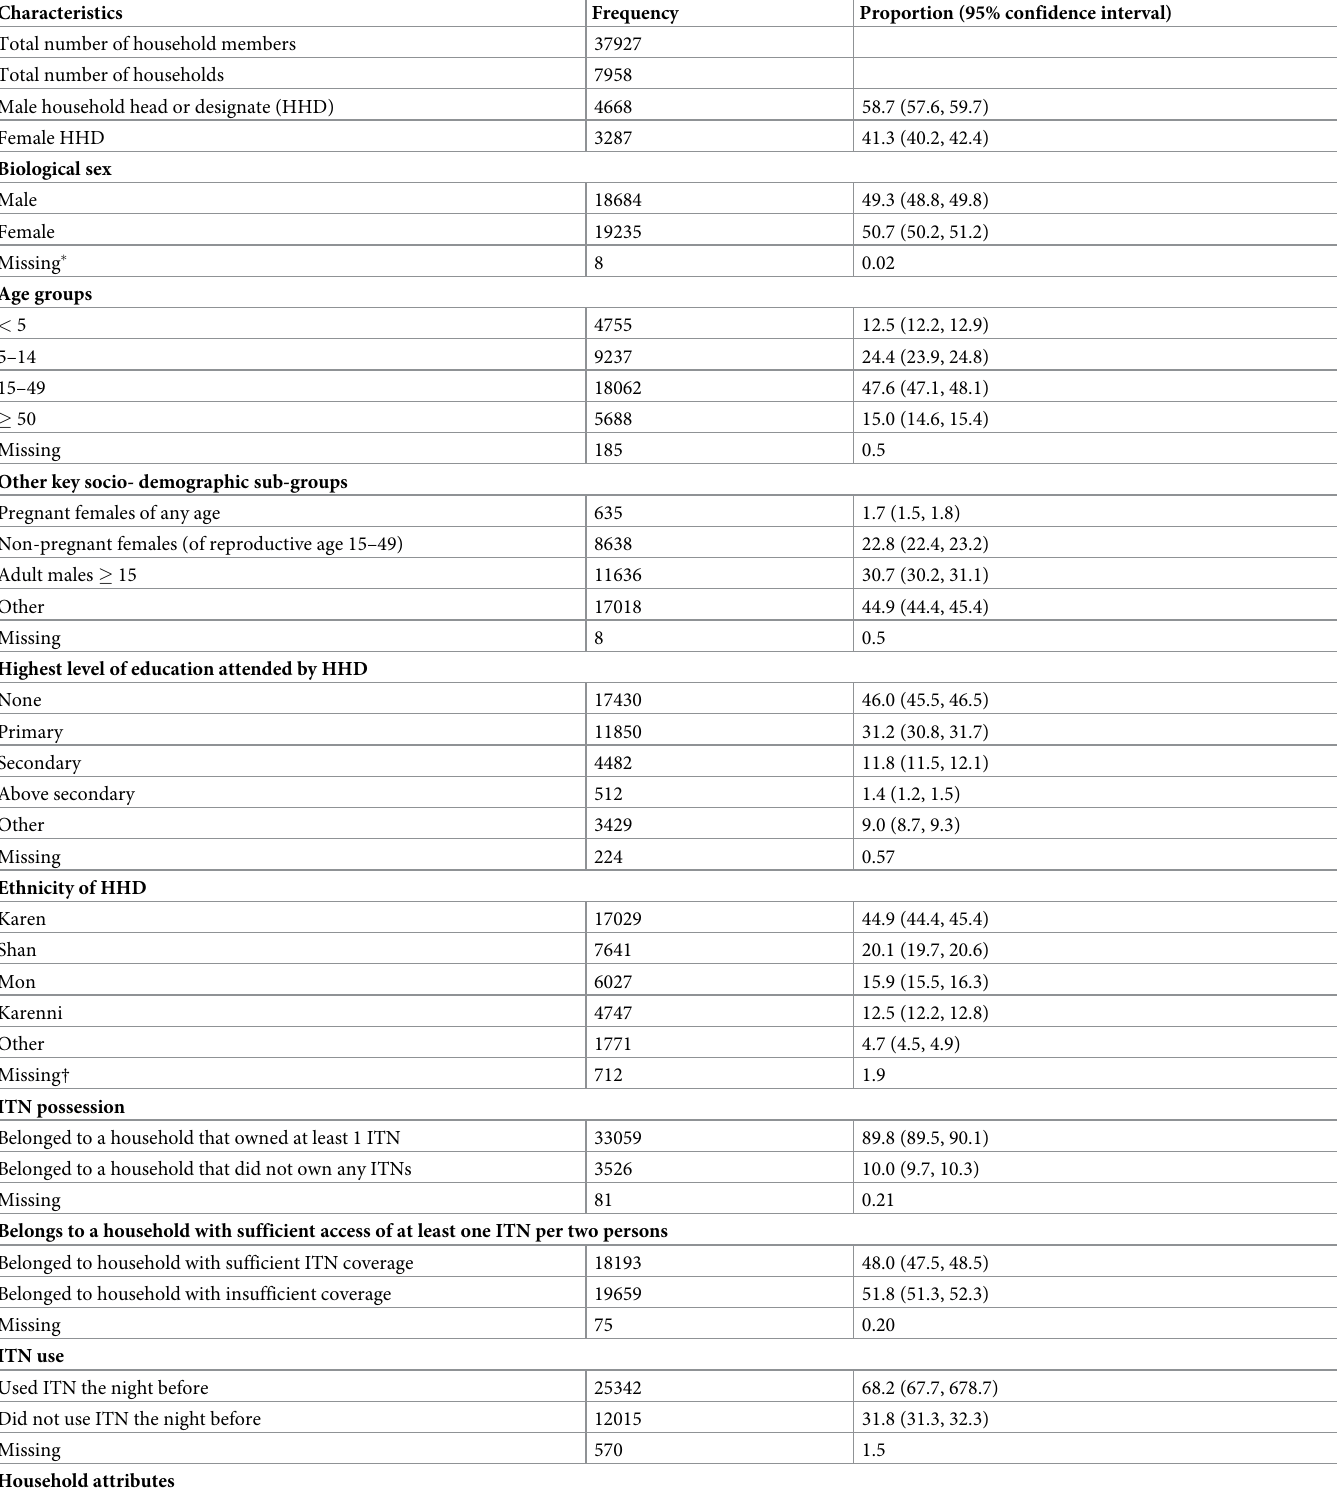
Table 1. Select sociodemographic characteristics of household members in the 2013 eastern Myanmar retrospective mortality survey sample (n = 37927).